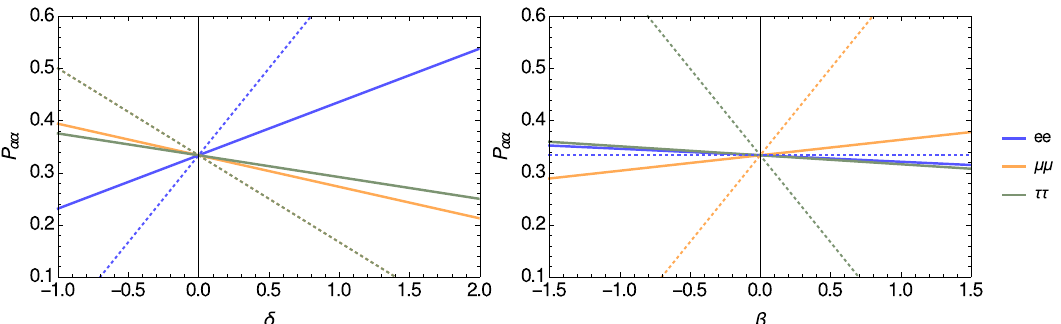
Figure 2. Probabilities to find cosmological neutrinos at different flavour states before (dotted) and after (solid) decoherence as a function of the initial distortions δ = δ ( q ) (left, β fixed to zero) and β = β ( q ) (right, δ fixed to zero). The initial distortion for electron neutrinos is δ /3, for muon neutrinos − δ /6 + β /3, and for tau neutrinos − δ /6 − β /3. The mixing angles are given by the global fit to neutrino-oscillation data [40] for the normal hierarchy and we assume a vanishing CP-violation